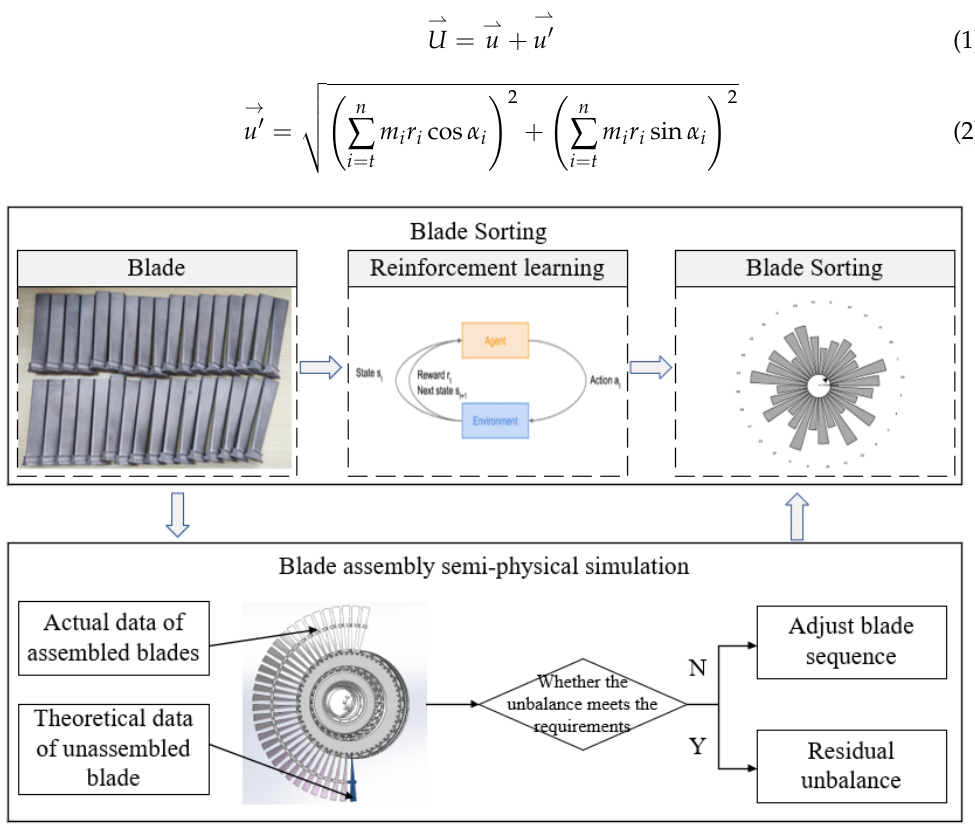
Figure 2. Single-stage blade semi-physical simulation.